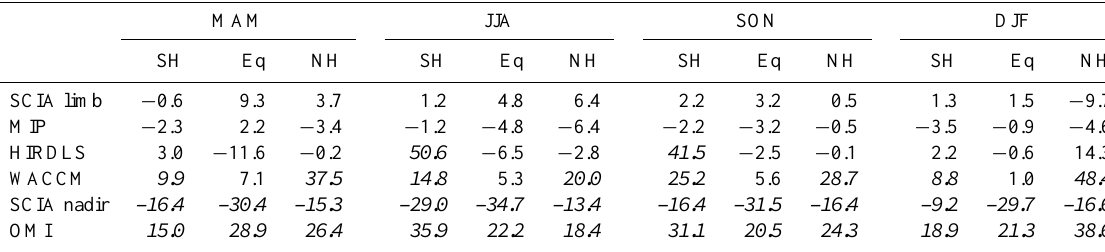
Table 4. Same as Table 3, but in percent (%) relative to the limb